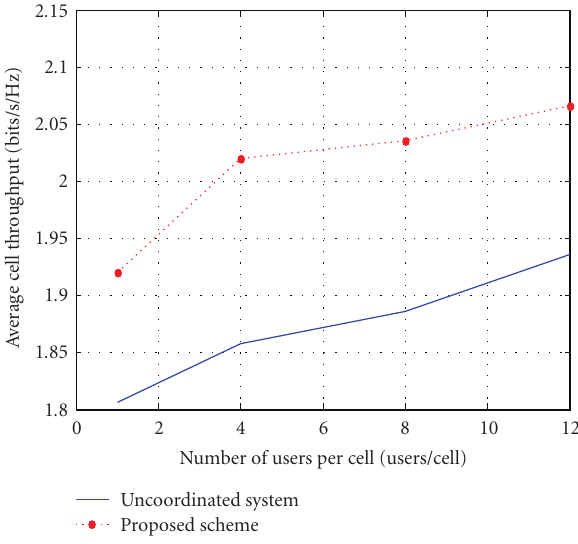
Figure 4: Average cell throughput comparison. Figure 5: Cell-edge user throughput comparison.